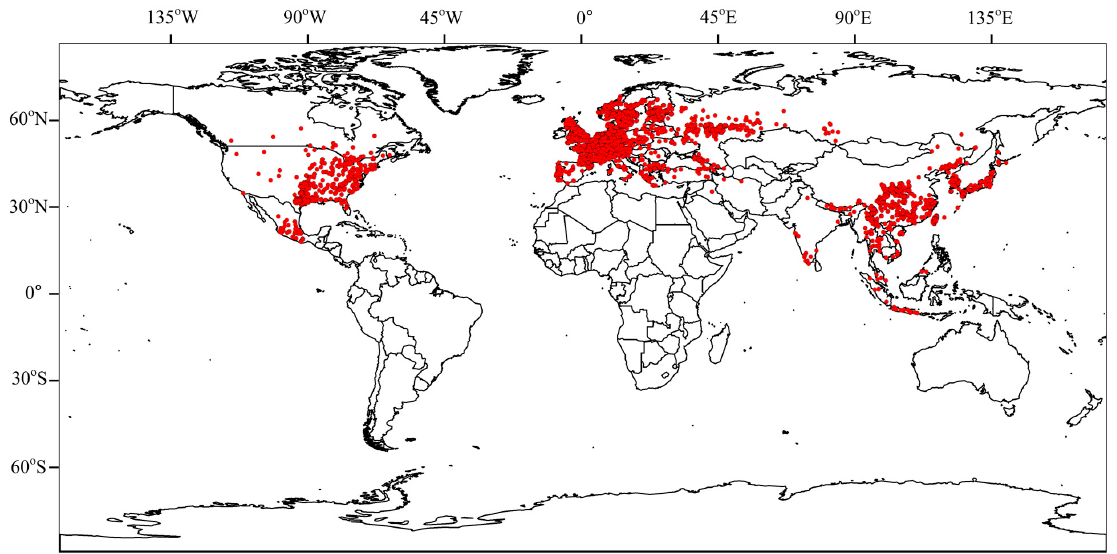
Figure 5. Global distribution of Panorpidae.